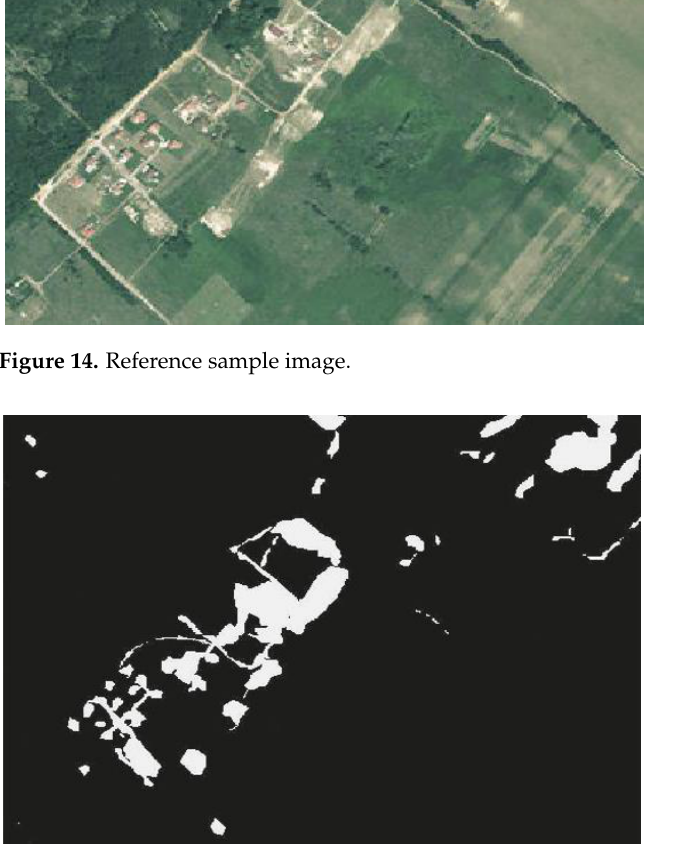
Figure 15. Visual comparison on change detection.